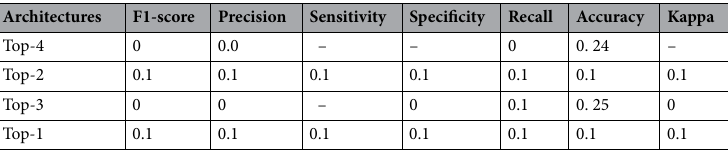
Table 11. Performance comparison for prediction of the four (4) best performing CNN architectures of the EOSA-NAS algorithm using AUC, precision, recall, sensitivity, specificity, accuracy and loss after full train for 60, 70 and 100